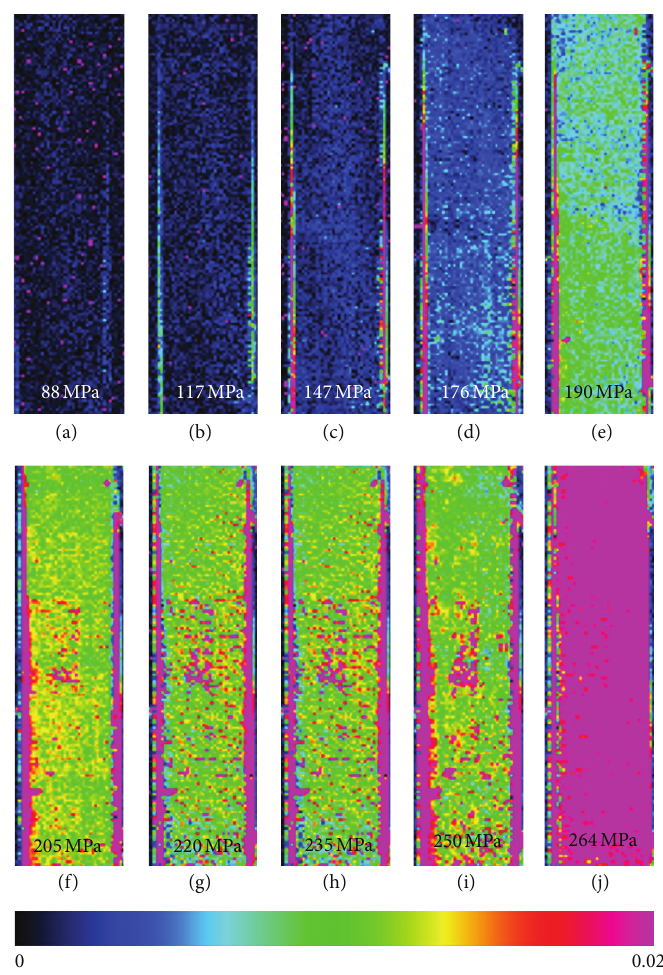
Figure 9: Thermographic pattern during fatigue loading of a SiC/BMAS